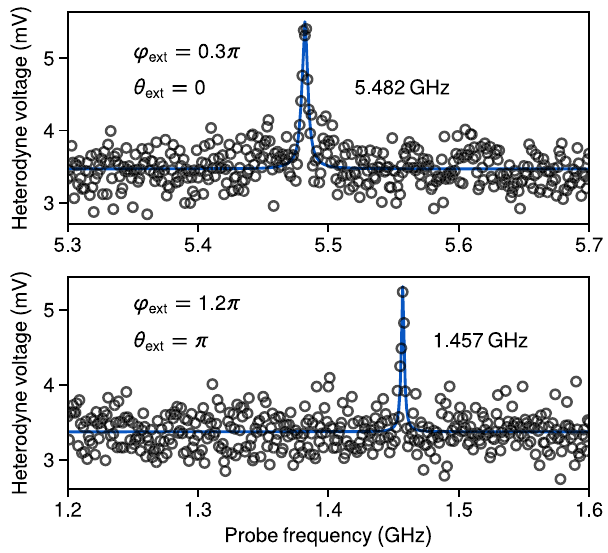
FIG. 6. Typical two-tone spectroscopy measurements, of the transition from the ground to fourth excited state at zero flux (top plot) and of that to the first excited state at half flux (bottom plot). Fitted Lorentzians are shown in blue.